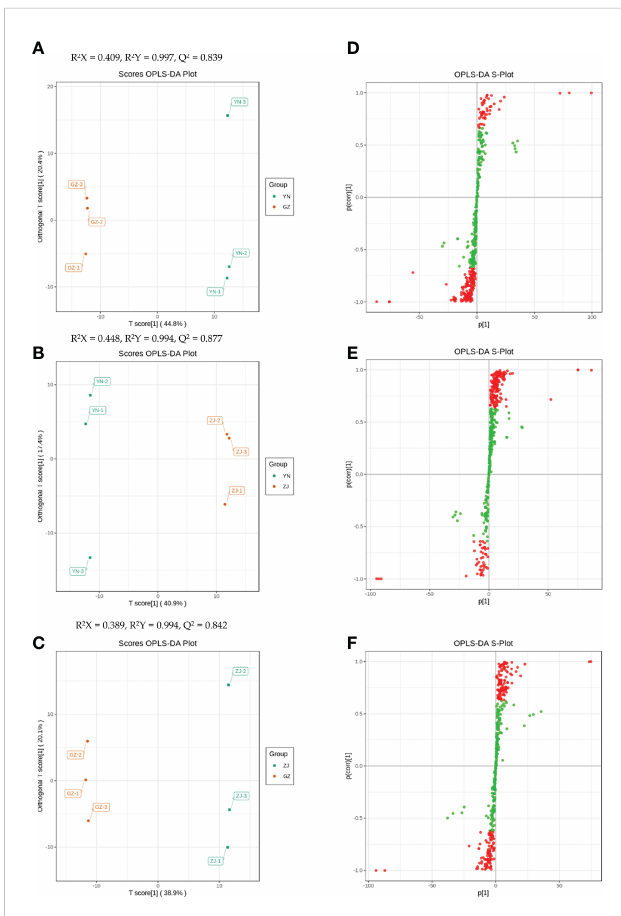
FIGURE 3 Orthogonal partial least squares-discriminant Analysis (OPLS – DA) scores. Scores of the OPLS – DA model with (A) YN vs GZ; (B) YN vs ZJ; (C) ZJ vs GZ. OPLS – DA s-plot model with (D) YN vs GZ; (E) YN vs ZJ; (F) ZJ vs GZ. R2Yscores and Q2values represent the interpretation rate of the model to the Y matrix and the prediction When Q2> 0.5, the model can be considered an effective model, And Q2> 0.9 is an excellent